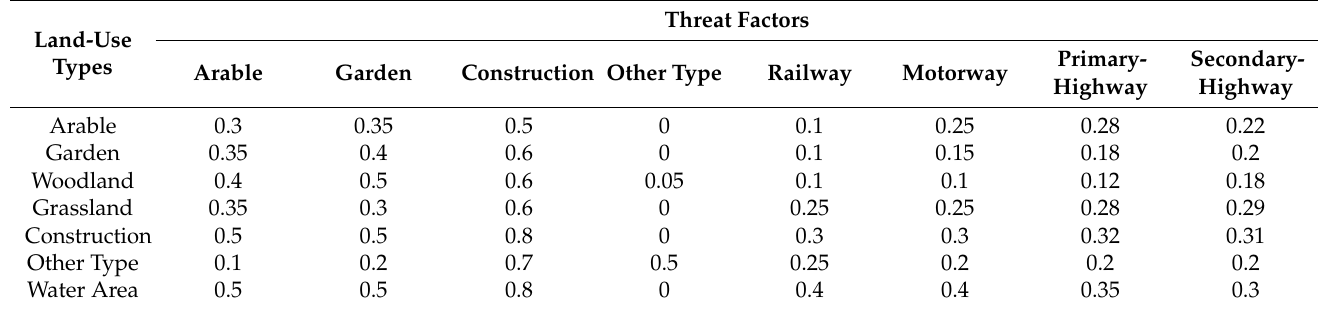
Table 5. Sensitivity score of habitat types to threat